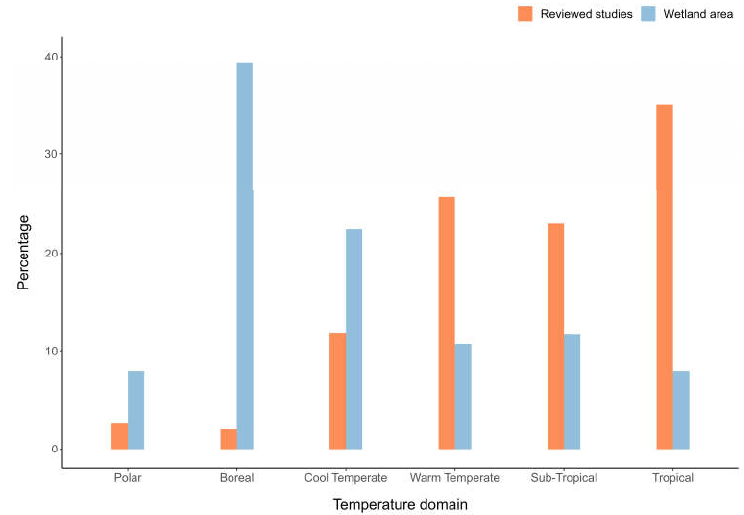
Figure 3. Distribution of the 351 reviewed studies and wetland areas [29] according to world temperature domains [30].